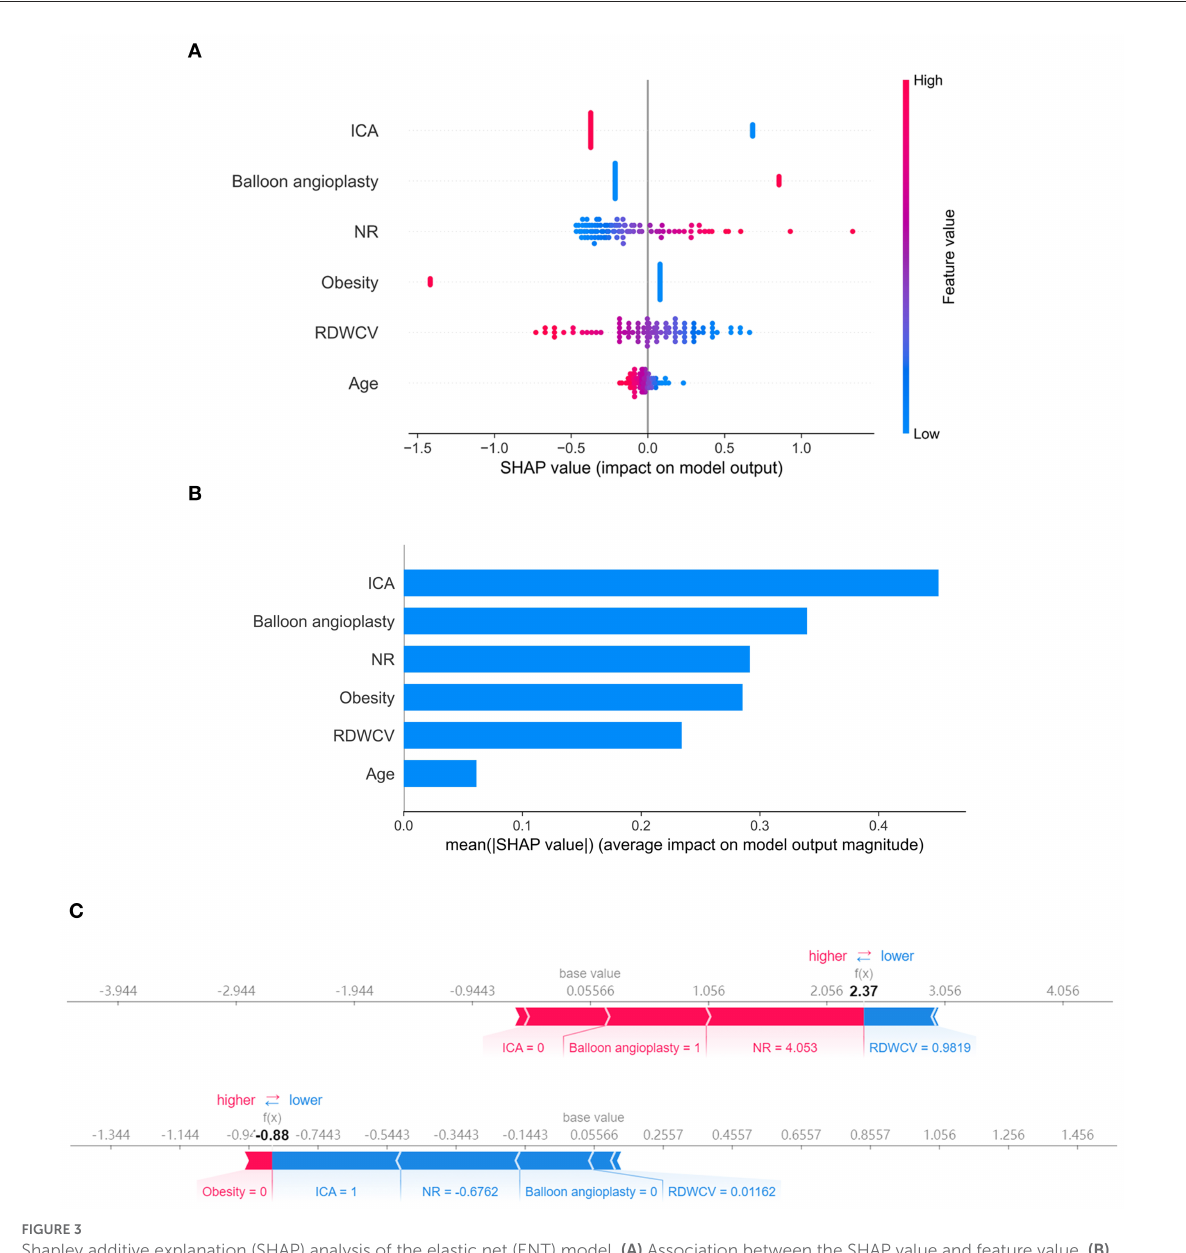
FIGURE3 Shapley additive explanation (SHAP) analysis of the elastic net (ENT) model. (A) Association between the SHAP value and feature value. (B) Feature importance (mean |SHAP value|) of each predictor. (C) Two ENT model prediction examples. ICA, internal carotid artery; NR, neck ratio; RDWCV, coefficient of variation of red cell volume distribution